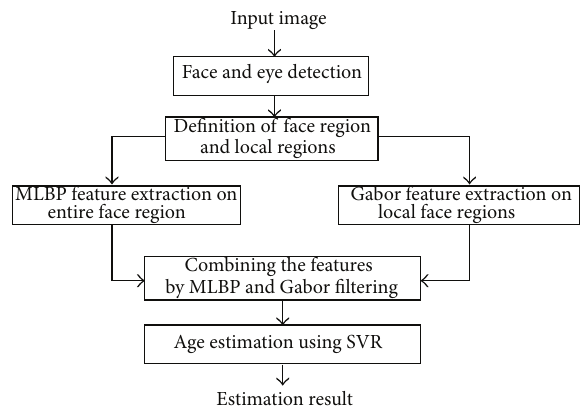
Figure 4: Proposed age estimation method based on MLBP, Gabor, and